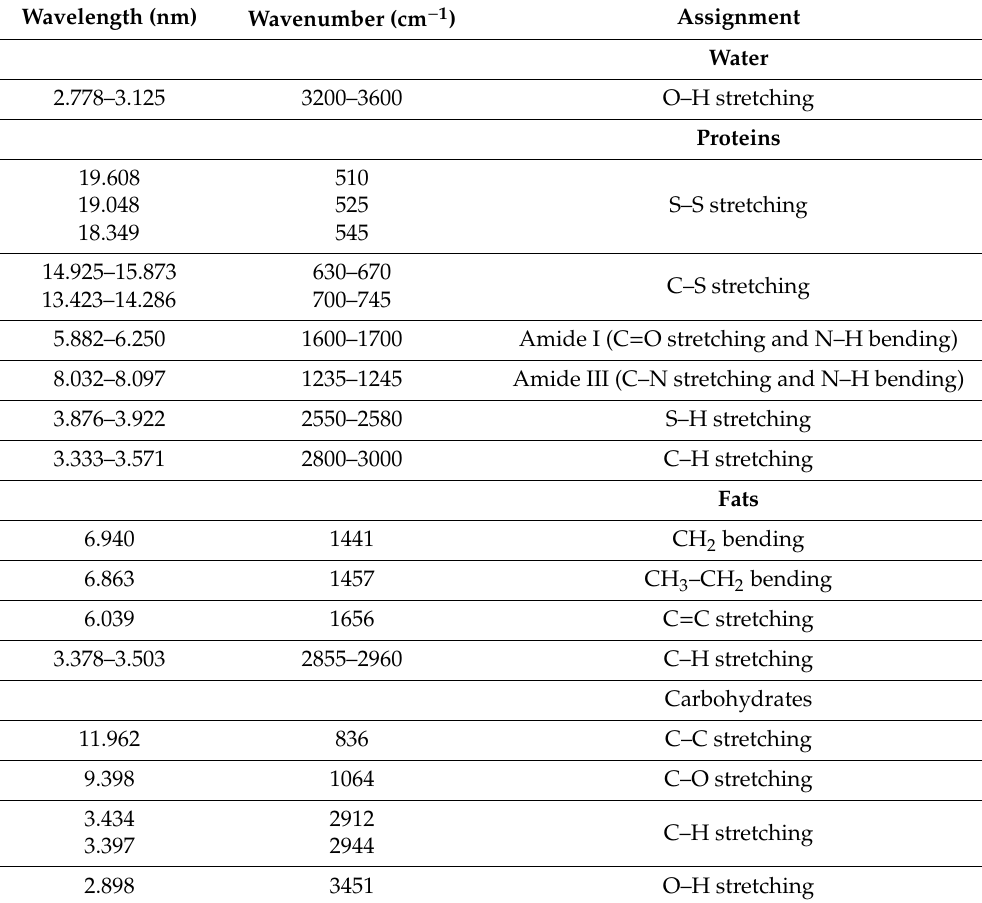
Figure 4. Light scattering schemes [17]. Reproduced with permission from A. Nawrocka, Advances in Agrophysical Research, Published by IntechOpen, 2013. Table 3. Examples of Raman bands